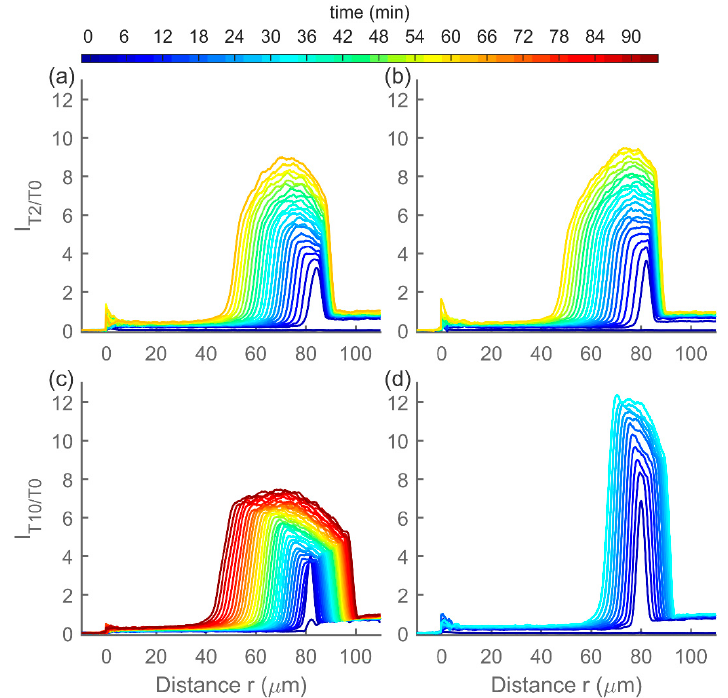
Figure 8. Spatiotemporal evolution of relative target (fluorescein labeled DNA- T2 or DNA- T10 ) concentrations I T2 / T0 and I T10 / T0 after exposure of DNA hydrogels to the DNA target solution at approximately t = 0. ( a , b ) Spatiotemporal hydrogel response to T2 for individually prepared hydrogels. ( c , d ) Spatiotemporal hydrogel response to T10 for individually prepared hydrogels. A profile is plotted for every third minute. Note that the time scale is different than that in Figure 7.